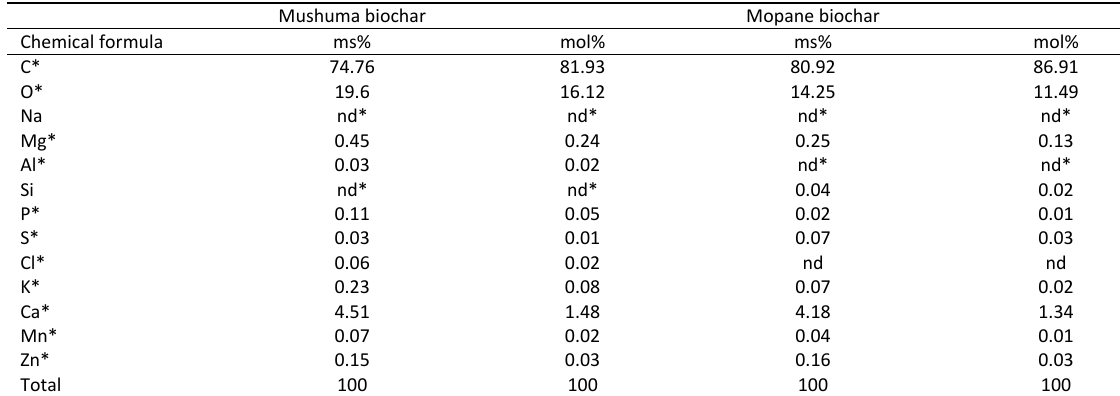
nd*-not detected